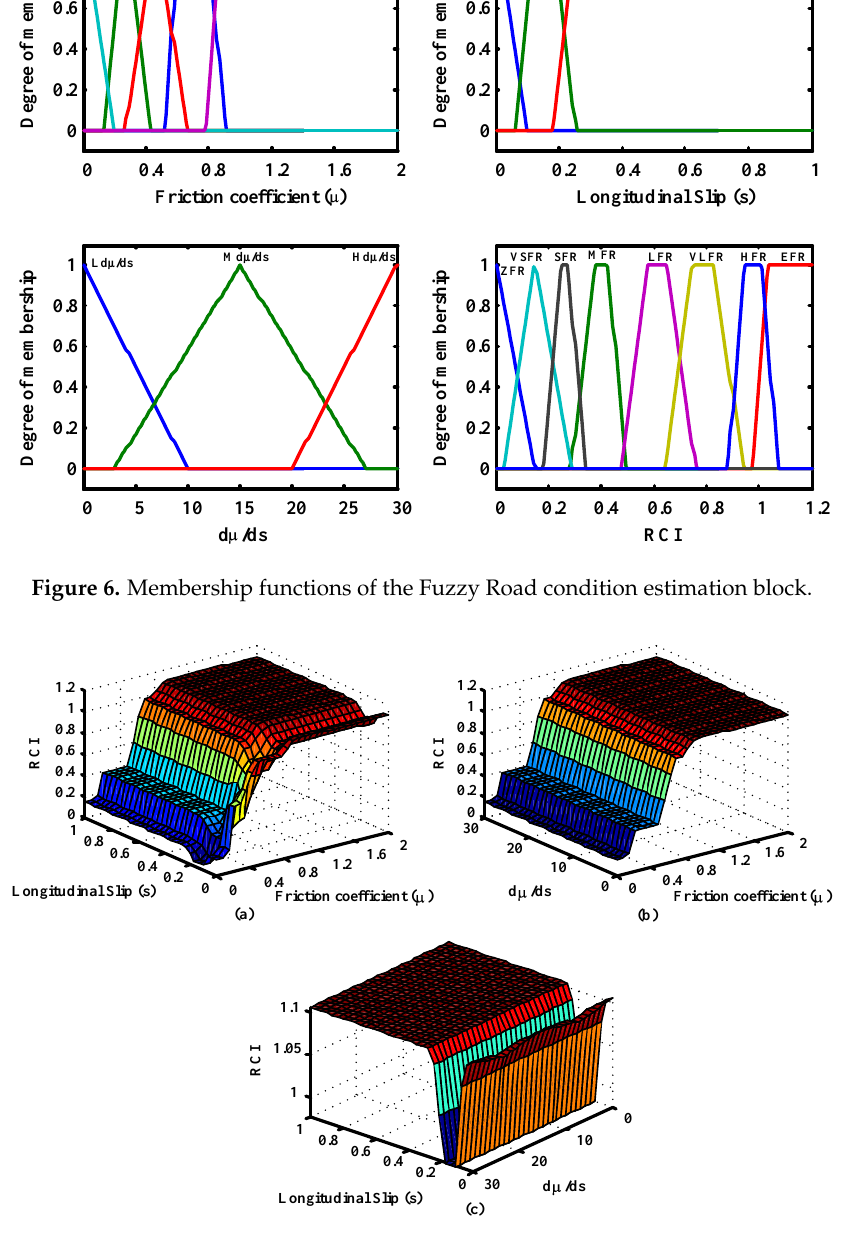
Figure 7. Output surfaces of the Fuzzy Road condition estimation block with dμ/ds. ( a ) RCI vs. Longitudinal Slip and Friction coefficient ( b ) RCI vs. dμ/ds and Friction coefficient ( c ) RCI vs. Longitudinal Slip and dμ/ds.